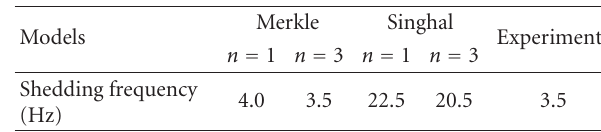
Table 1: Comparison of the measures and predicted cavity shedding frequencies for the Merkle and Singhal cavitation